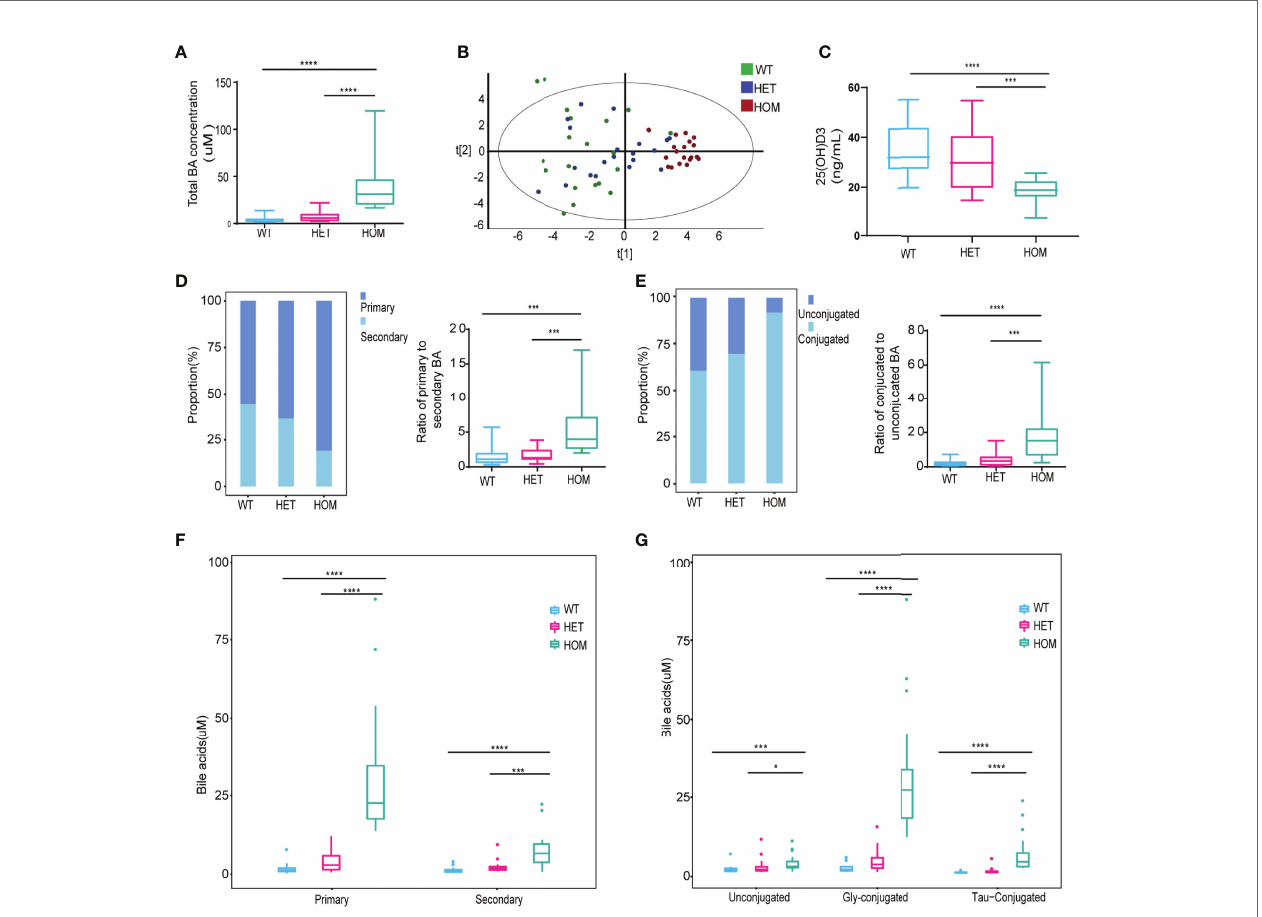
FIGURE 2 | The pro fi le of bile acids (BAs) in the serum was signi fi cantly altered in homozygotes carrying the p.Ser267Phe mutation. (A) Levels of total BAs in serum. (B) PCA of WT, HET, and HOM individuals using all BAs identi fi ed. (C) Levels of 25(OH)D3 in serum. (D) Stack bar plot representing the proportion of total primary and secondary BAs, and box and whisker plots for the primary to secondary BAs ratio. (E) Stack bar plot representing the proportion of total conjugated and unconjugated BAs, and box and whisker plots for the conjugated to unconjugated BAs ratio. (F) Primary and secondary BAs. (G) Concentrations of unconjugated, Gly-conjugated, and Tau-conjugated BAs in serum. *, p < 0.05; ***, p < 0.001; and ****, p <